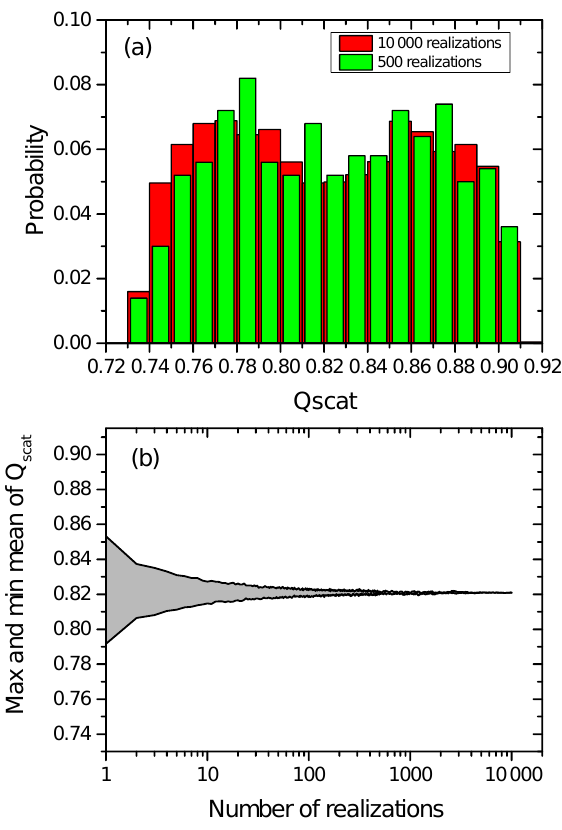
Figure 2. (a) Probability distribution of Q scat for a phase-separated particle with the eccentric core positioned at 500 random locations (green columns) and 10000 random locations (red column) within the volume of a 100 nm diameter particle at OIR = 1 : 4 n( core ) = 1 . 429 + i · 0, n( shell ) = 1 . 571 + i · 0 . 84. (b) Maximum and minimum of the mean for Q scat for random realization of the position with the number of realizations used for the